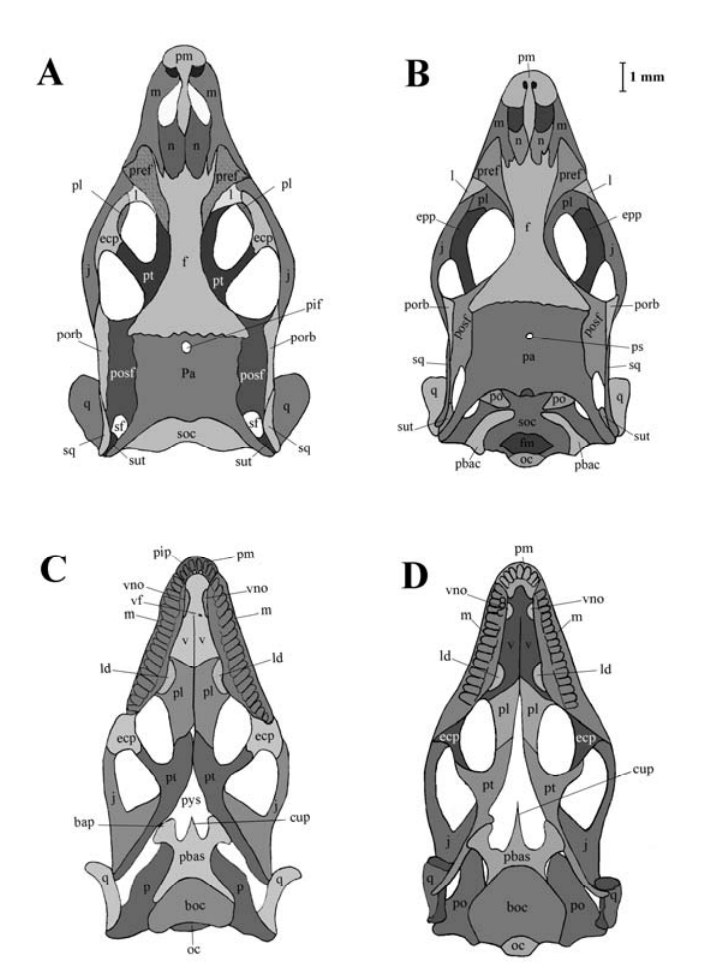
F IGURE 1. Dorsal view of the skulls of Eremias persica (A) and Mesalina watsonana (B). Palatal view (ventral view) of Eremias persica (C) and Mesalina watsonana (D). Abbreviations: ecp, ectopterygoid; f, frontal; fm, foramen magnum oc, occipital; pbas, parabasisphenoid; po, prootic j, jugal; l, lacrimal; m, maxilla; n, nasal; pa, parietal; pl, palatine; pref, prefrontal; q, quadrate; sq, squamosal; pt, pterygoid; pif, pineal foramen; pm, premaxilla; posf, postfrontal; porb, postorbital; q, quadrate; sf, supratemporal fossa; soc, supraoccipital; sut, supratemporal;. Scale bar: 1 mm. Posterolaterally, the frontal articulates with the anteromedial margin of the postfrontal. The transverse posterior margin of the frontal lies anterior to the posterior margin of the orbits and articulates with the anterior margin of the